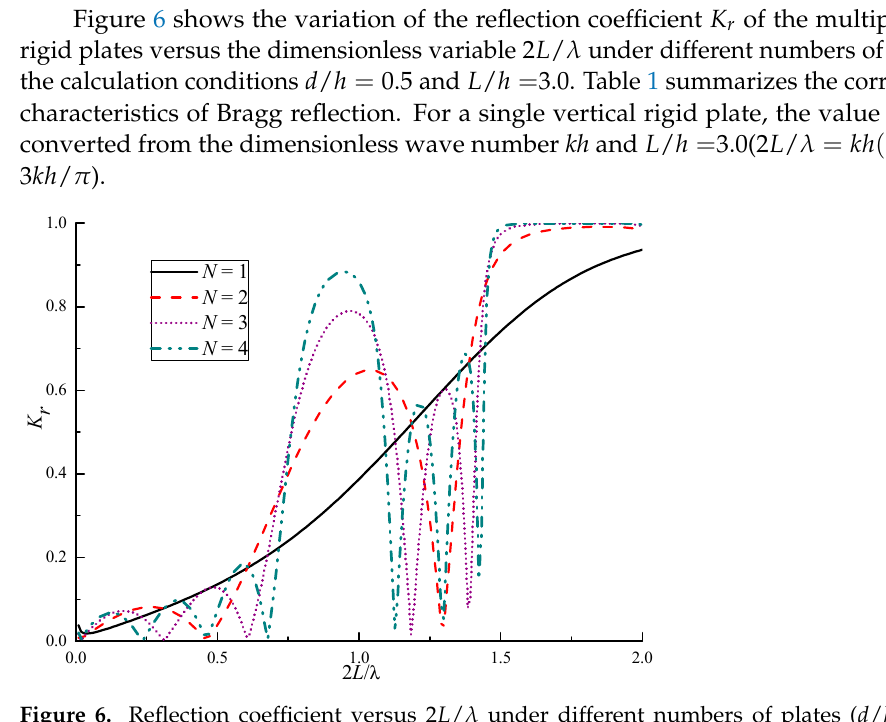
Table 1. Characteristics of Bragg reflection under different numbers of plates (